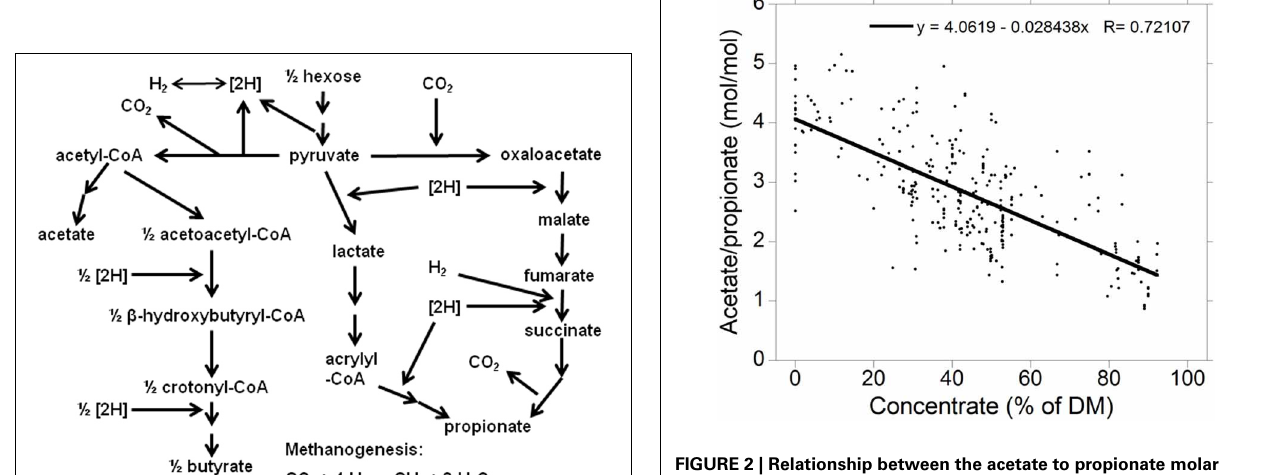
FIGURE 2 | Relationship between the acetate to propionate molar concentration ratio and the percentage of concentrate in the diet dry matter (DM) for 300 treatment means in 73 experiments (Ungerfeld,